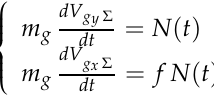
Figure 3. Change in the velocity component of the granule along the X axis after its collision with the processed part F fr = N ( t ) f